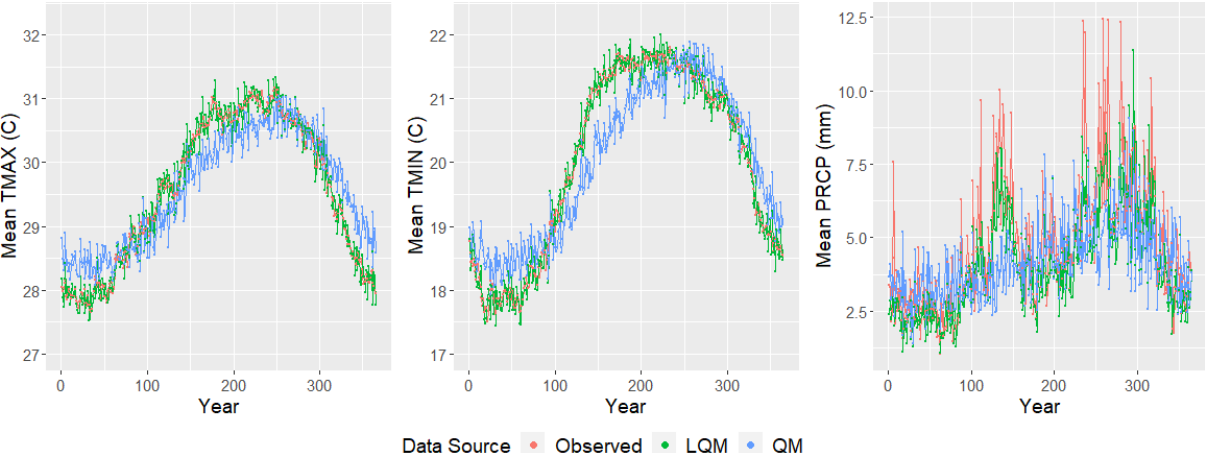
Figure 11. Average TMAX (left), TMIN (middle), and PRCP (right) across all 23 stations from 1980 to 2005. The true historical GHCN observations are plotted in red, while the LQM bias-corrected fitted values and QM bias-corrected fitted values are plotted in green and blue, respectively. This figure was created using Wickham (2016).